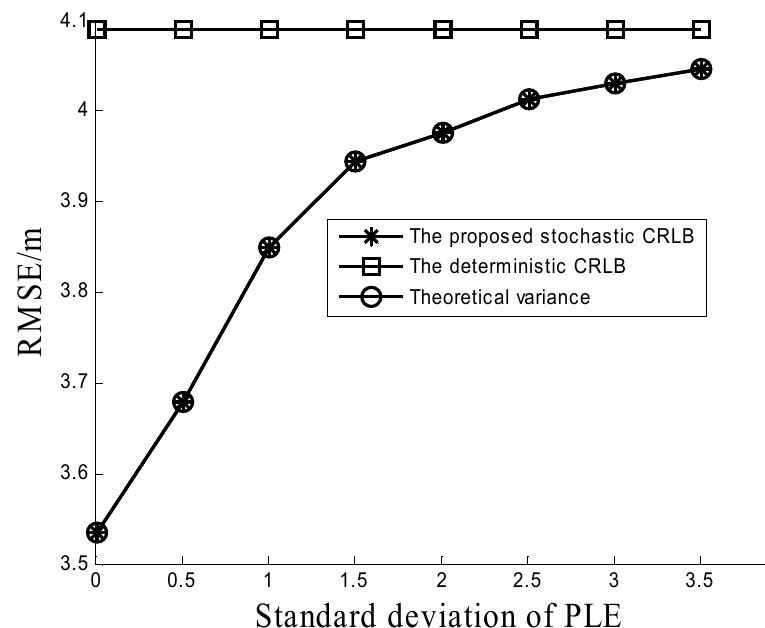
Figure 5. Comparison among the proposed stochastic CRLB, the deterministic CRLB, and the theoretical variance of the proposed method under different PLE uncertainties.